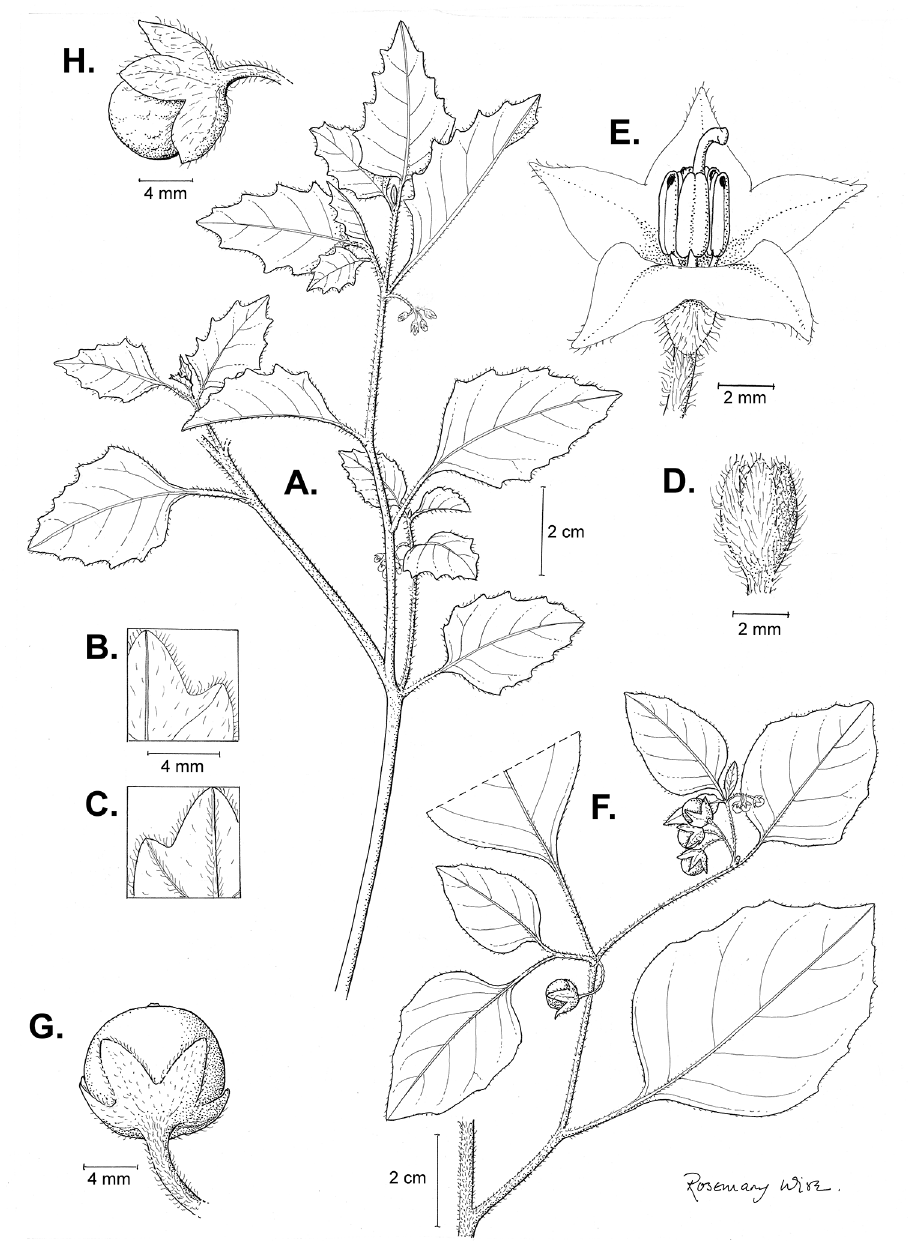
Figure 45. Solanum sarrachoides Sendtn. A Habit B detail of adaxial leaf surface C detail of abaxial leaf surface D bud E flower F fruiting habit G maturing fruit ( A–E Macoun s.n. ; F, G Ahles 55038 ). Drawing by R. Wise (previously published in “PhytoKeys